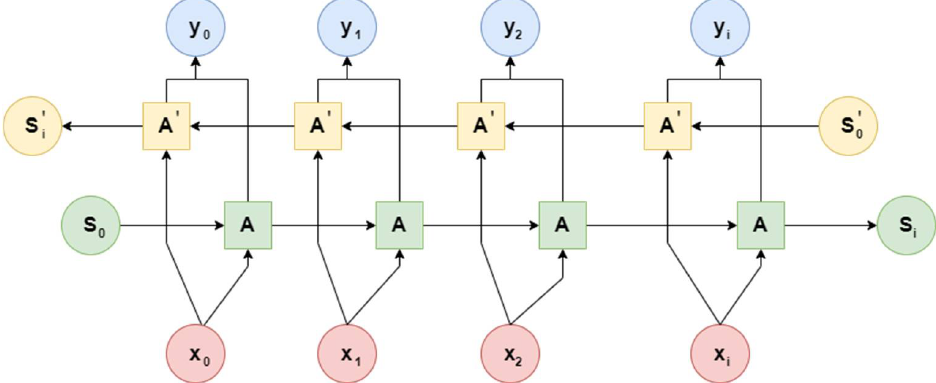
Figure 3. Bi-LSTM Neural Network .